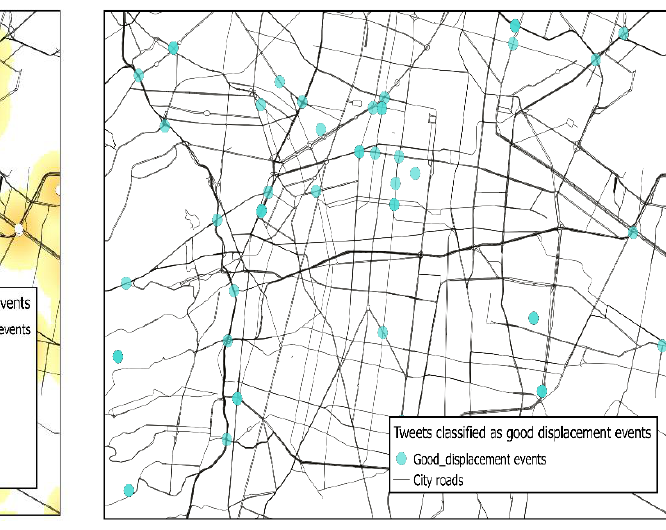
Figure 3. Tweets classified as traffic events.